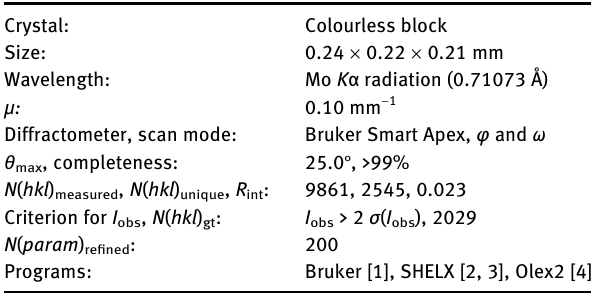
Table 1 contains crystallographic data and Table 2 contains the list of the atoms including atomic coordinates and displacement parameters.